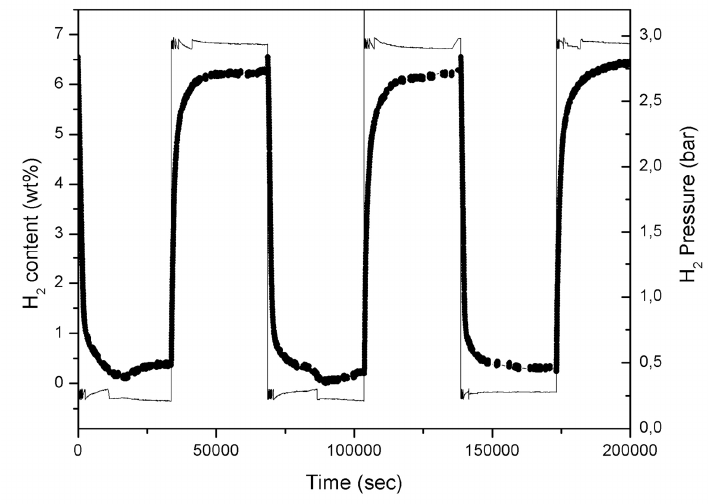
desorption and absorption curve of three cycles for 5% Fe-doped MgH Figure 1. H 2 powder: scatter line; hydrogen pressure profile is also superimposed: full